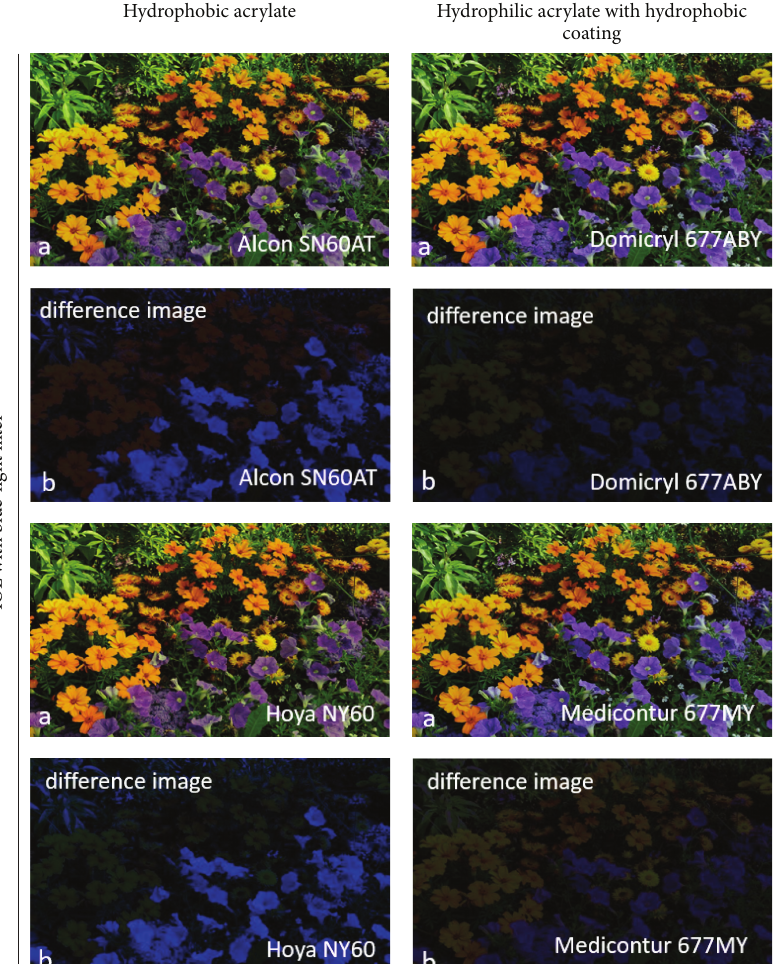
Figure 10: (a) Influence of the specific transmittance curves on the reference image for hydrophobic IOL materials and hydrophilic IOL materials with a hydrophobic coating, in each case with blue-light filter. (b) Difference between reference image and the image affected by a special transmittance curve for each IOL (for enhanced visualization, the brightness value was increased by a factor